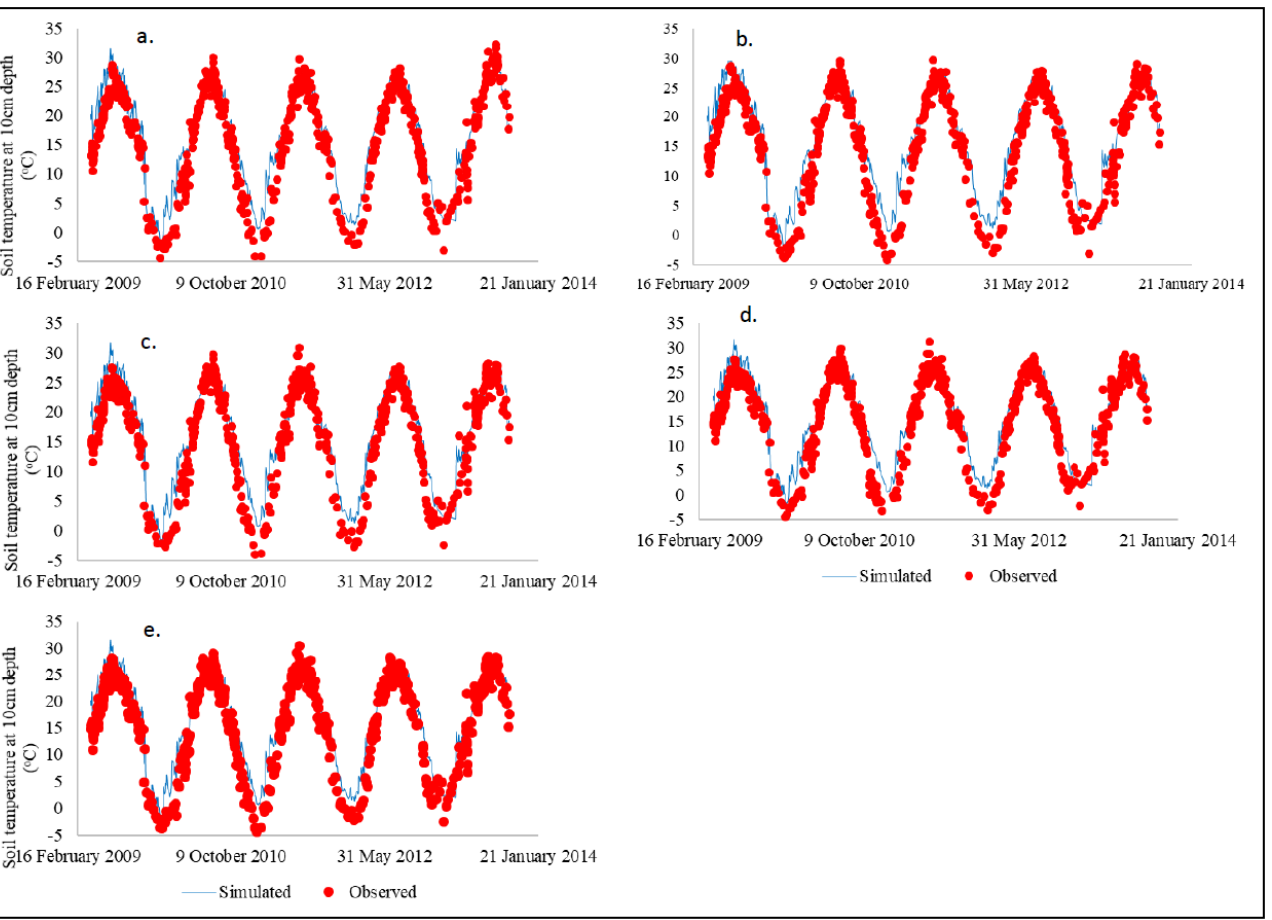
Figure 1. Comparisons between field observed ( ● ) and DNDC simulated (line) daily soil temperatures ( o C) at the conventional winter wheat-summer maize double-cropping system (Chem. W/M; a.), optimized winter wheat-summer maize double-cropping system (Opt. W/M; b.), winter wheat-summer maize-fallow-spring maize system (W/M-M;.c.), winter wheat-summer soybean-fallow-spring maize system (W/S-M; d.), and spring maize system (M; e.) over the experimental period from June 2009 to June 2013. The r2 ranged from 0.94 to 0.95 and the overall r2 is 0.94.